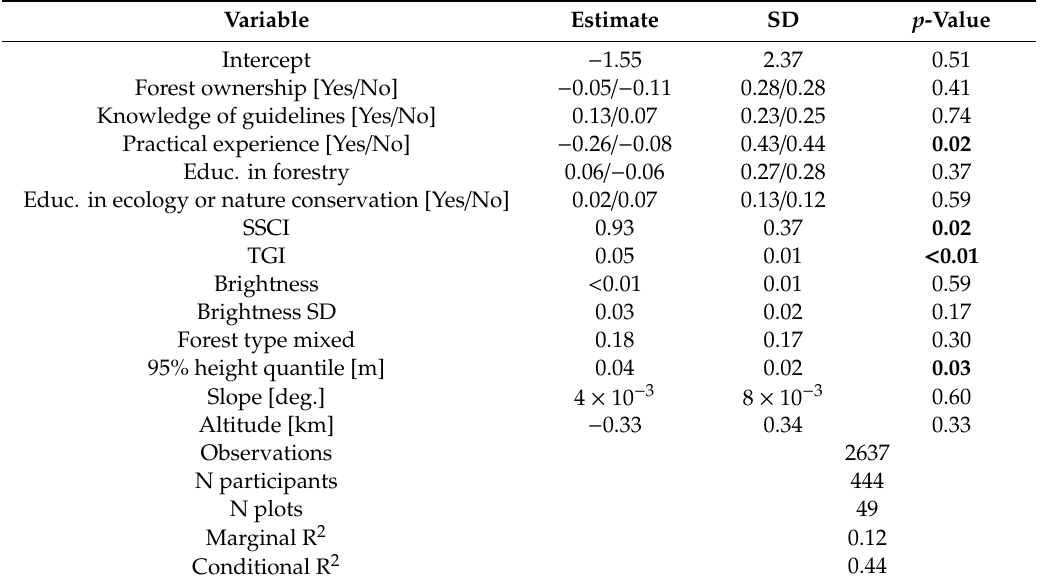
Table 2. Model parameter estimates, standard deviations (SD) and p -values. Variable p